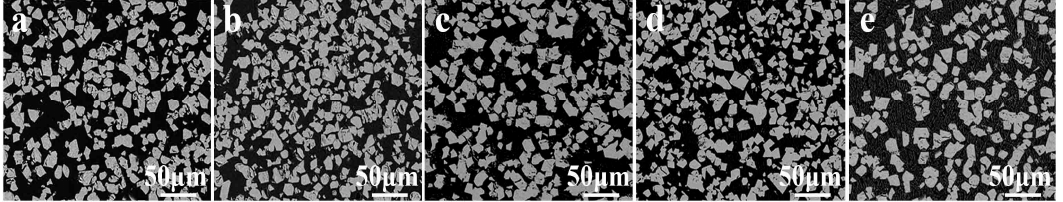
Figure 8. SEM images of cooled samples at various basicity. ( a ) 0.6; ( b ) 0.7; ( c ) 0.8; ( d ) 0.9; ( e ) 1.0.